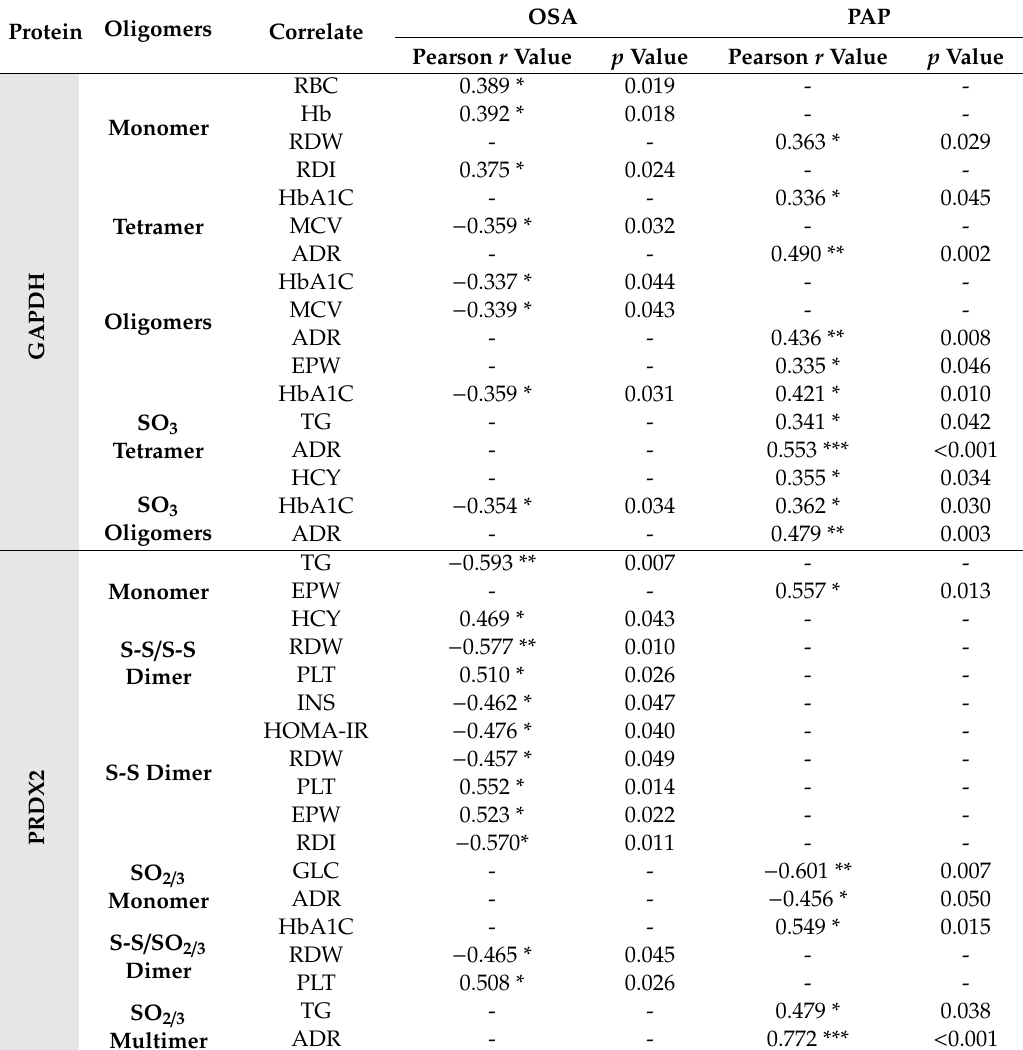
Table 4. Correlation of the di ff erent redox / oligomeric states of GAPDH and PRDX2 with the study clinical parameters in OSA patients before and after PAP